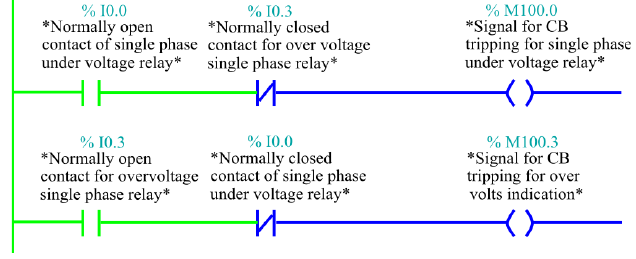
Fig. 9. Protection scheme of under/overvoltage for analogue/digital